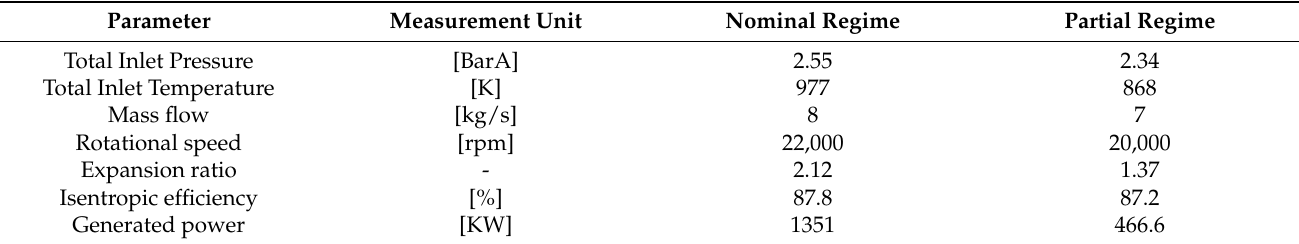
Table 3. Nominal and partial regime